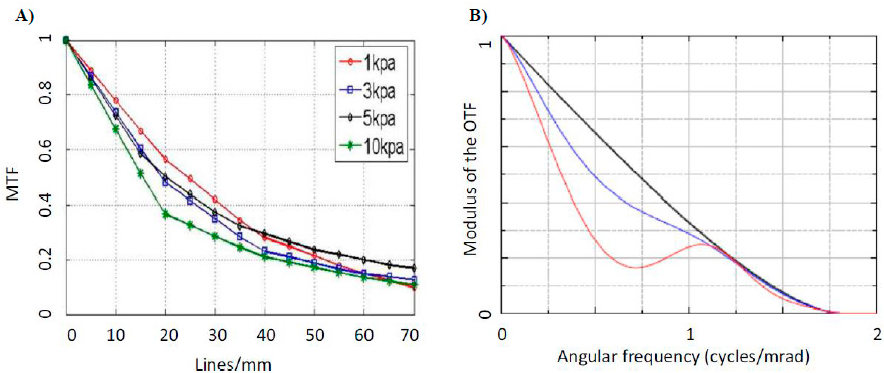
Figure 7. ( A ) Experimentally measured MTF curves of tunable liquid lenses under increasing pneumatic pressure from 1 to 10 kPa. With kind permission of the Optical Society of America (OSA). Adapted from Zhang, W.; Aljasem, K.; Zappe, H.; Seifert, A. Highly flexible mtf measurement system for tunable micro lenses. Opt Express 2010, 18 , 12458–12469 . ( B ) The MTF of the astigmatic lens along two axes: tangential (T) and sagittal (S) vs. frequency. The black curve signifies the diffraction-limited MTF. With kind permission of the Optical Society of America (OSA). Adapted from Lima, N.C.; Cavalli, A.; Mishra, K.; Mugele, F. Numerical simulation of astigmatic liquid lenses tuned by a stripe electrode. Opt. Express 2016 , 24 , 4210–4220.